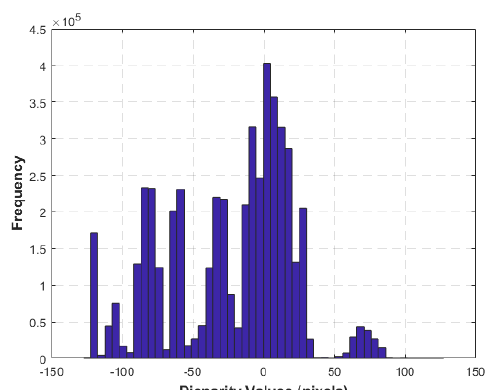
Figure 2. Example of the histogram of the disparity values in a disparity map.